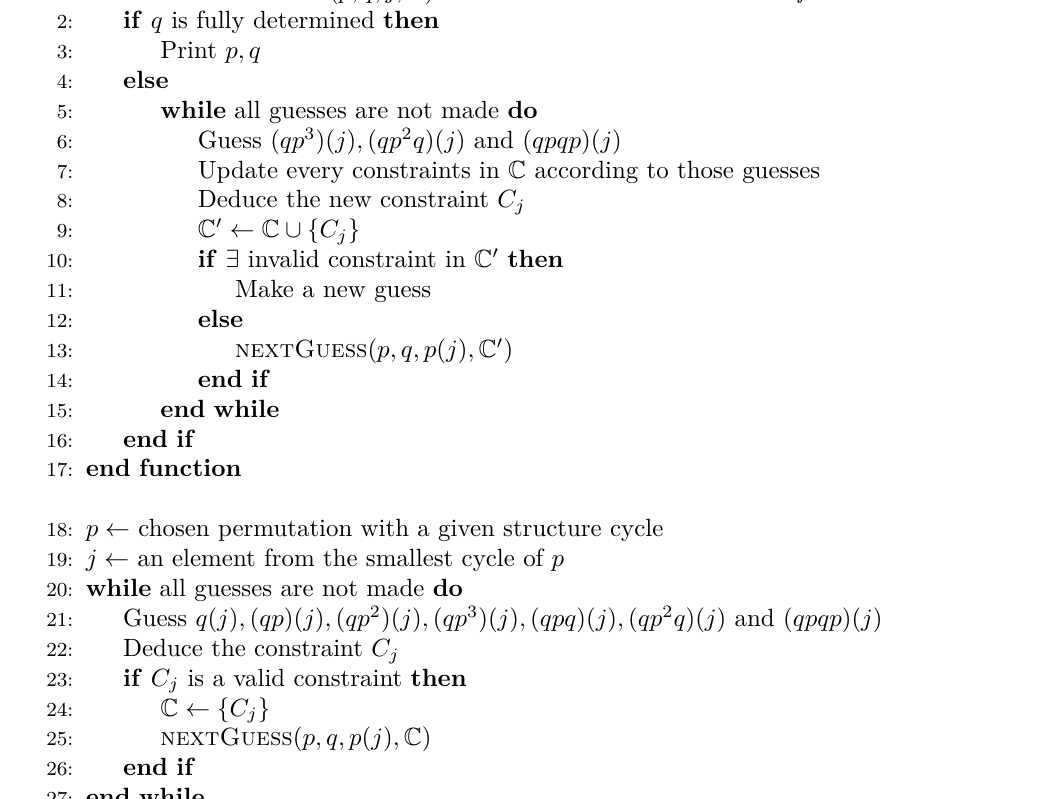
Algorithm 1 Searching for optimal even-odd permutations over 9 rounds